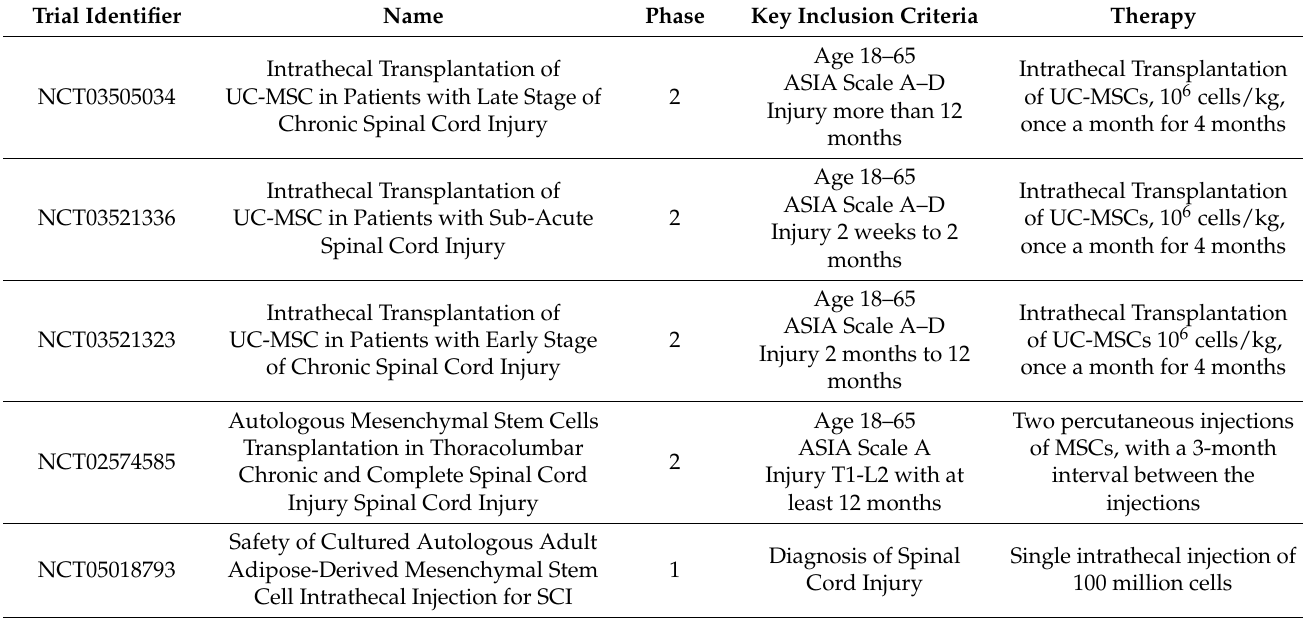
Table 1. Active clinical trials utilizing mesenchymal stem cells for spinal cord injury.